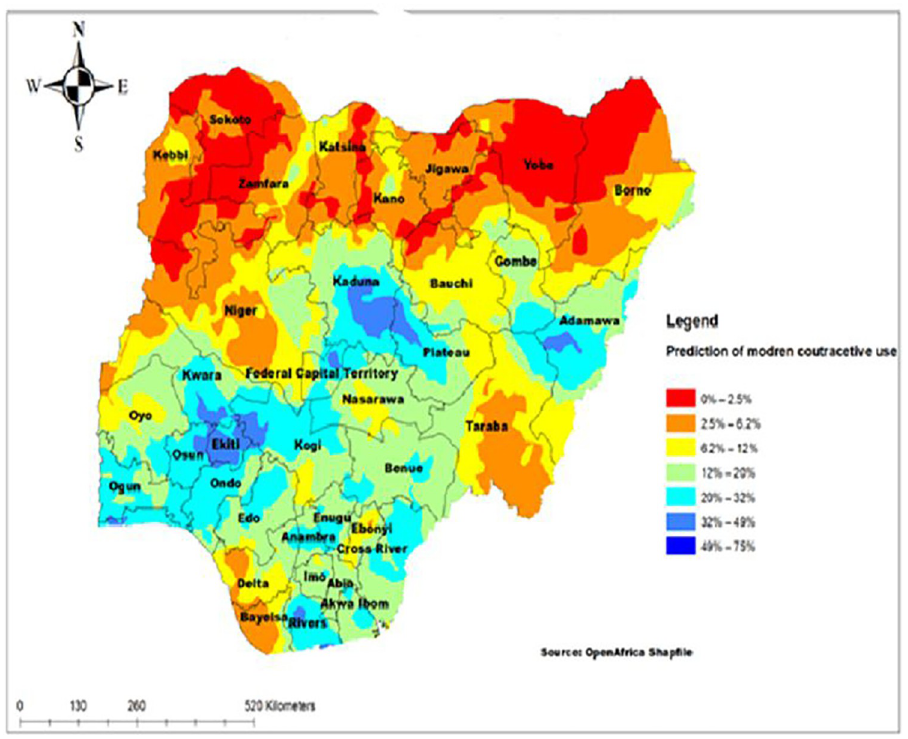
Fig 4. The prediction of modern contraceptive use in Nigeria,